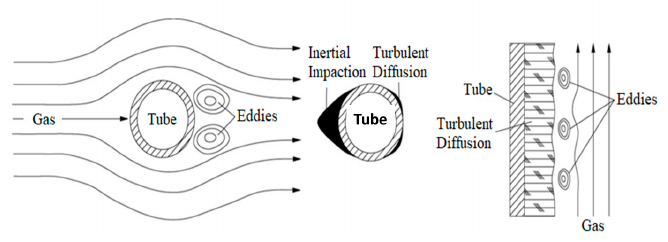
Figure 15. Gas flow and deposition patterns.